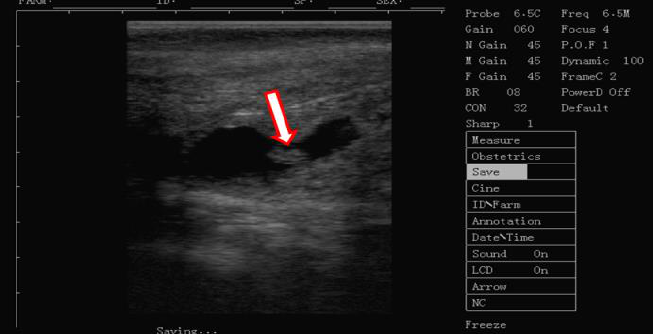
Figure 1. Buffalo embryos on the day 30 using trans-rectal ultrasonography